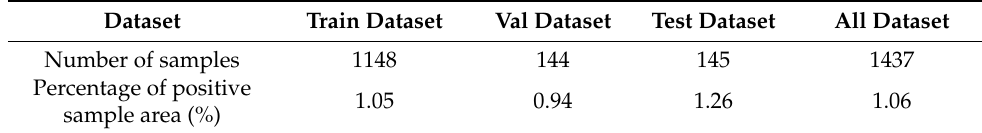
Table 2. Percentage of positive samples in the